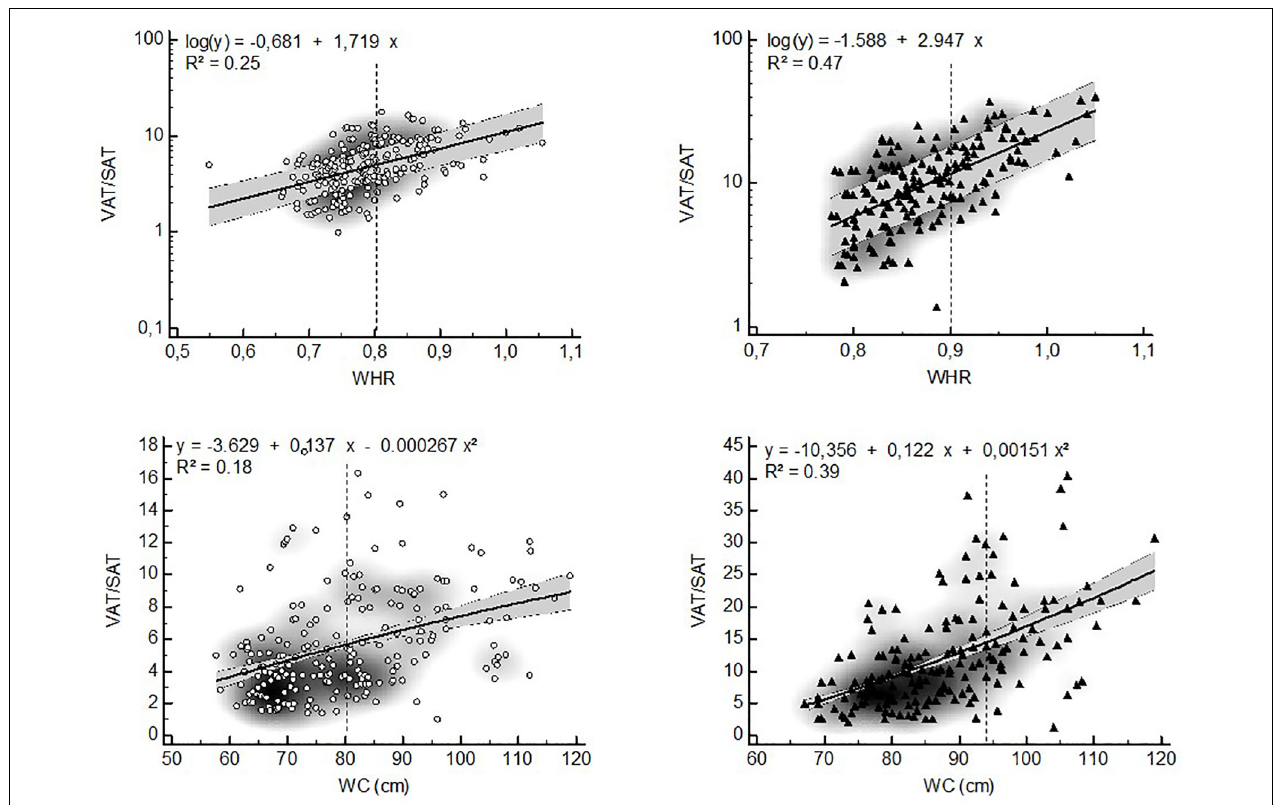
FIGURE 3 | Non-linear relationships between the VAT/SAT ratio and anthropometric estimates of visceral adiposity ( (cid:78) = women, (cid:78) = men, VAT = visceral adipose tissue, SAT = subcutaneous adipose tissue, WHR = waist-to-hip ratio, WC = waist circumference, dashed lines represent WHO (25) cut points for increased cardiometabolic risk in whites, gray zone represents 95% confidence